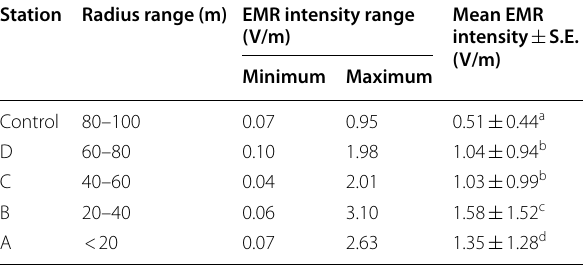
Table 2 Range and mean EMR intensity values at different sampling